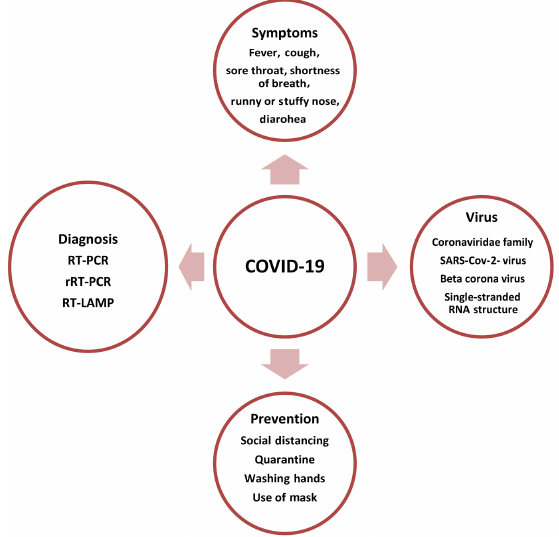
Fig. 1 Overview of